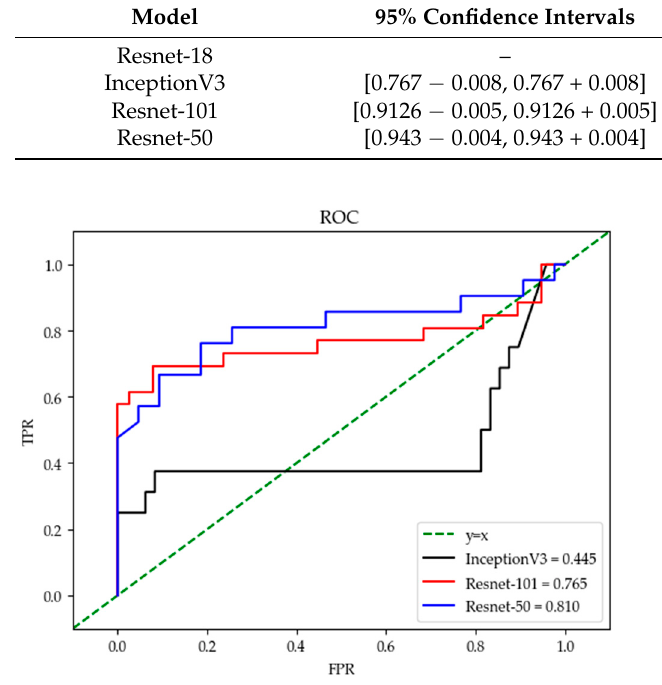
Figure 7. Comparison results of ROC curves for the three models.